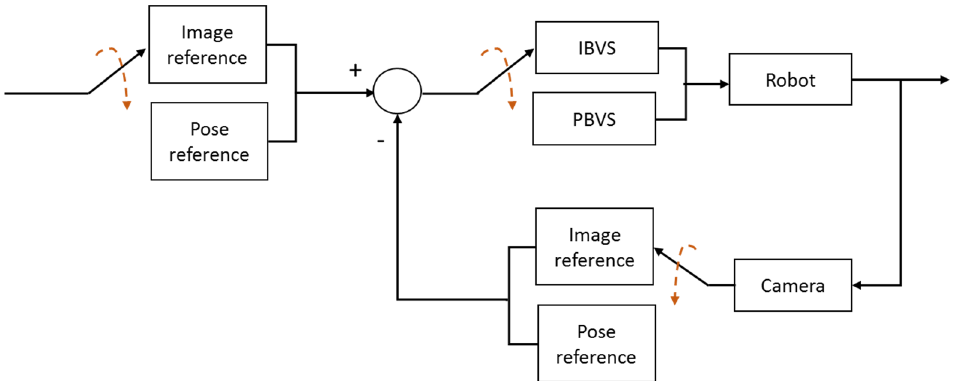
Figure 3. Proposal for a Hybrid Control System structure.